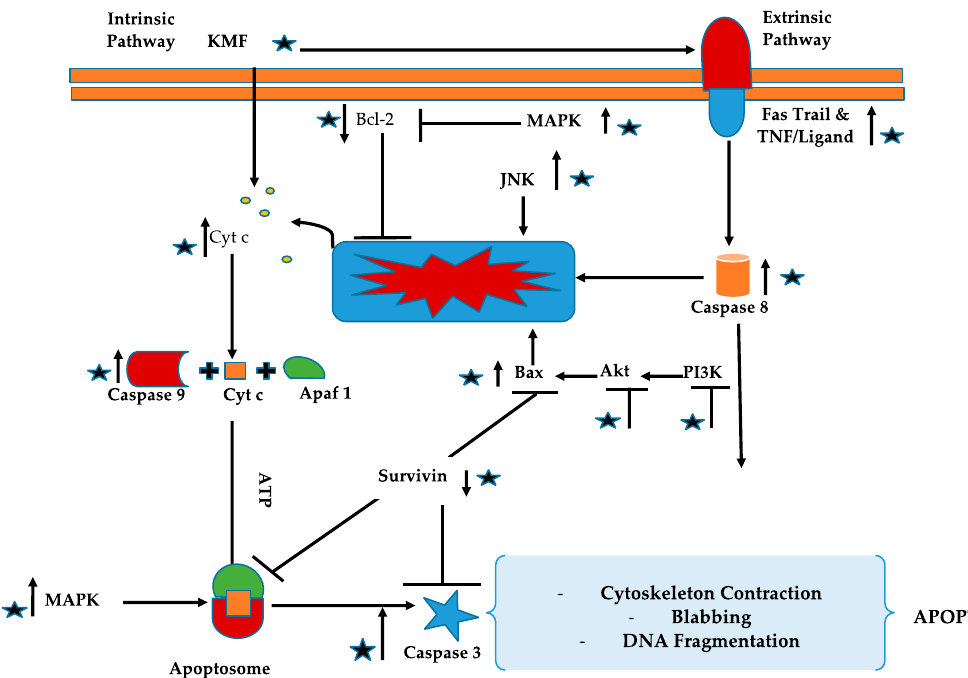
Figure 2. Anticancer role of kaempferol: Mechanistically, it can induce anticancer effects mainly through downregulation of the expressions of proteins involved in the cancer progression and formation alongside apoptosis induction, cell cycle arrest, and decreasing the expression for anti-inflammatory proteins.